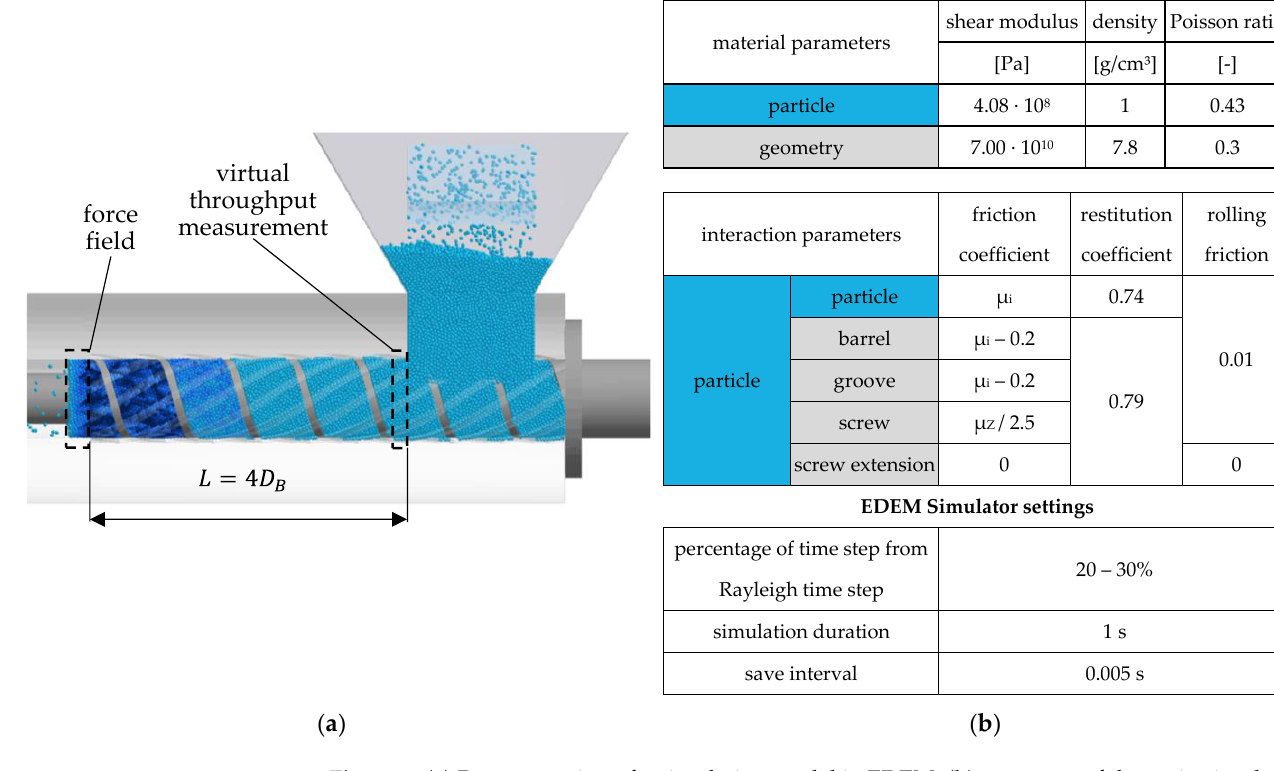
Figure 5. ( a ) Representation of a simulation model in EDEM; ( b ) summary of the main simulation settings in EDEM.